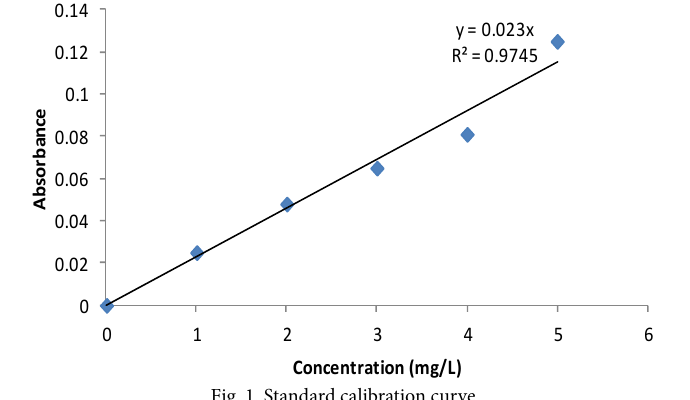
Fig. 1. Standard calibration curve Table 2. Effect of adsorbent dose Table 2. Effect of adsorbent dose Fig. 1 Standard calibration curve